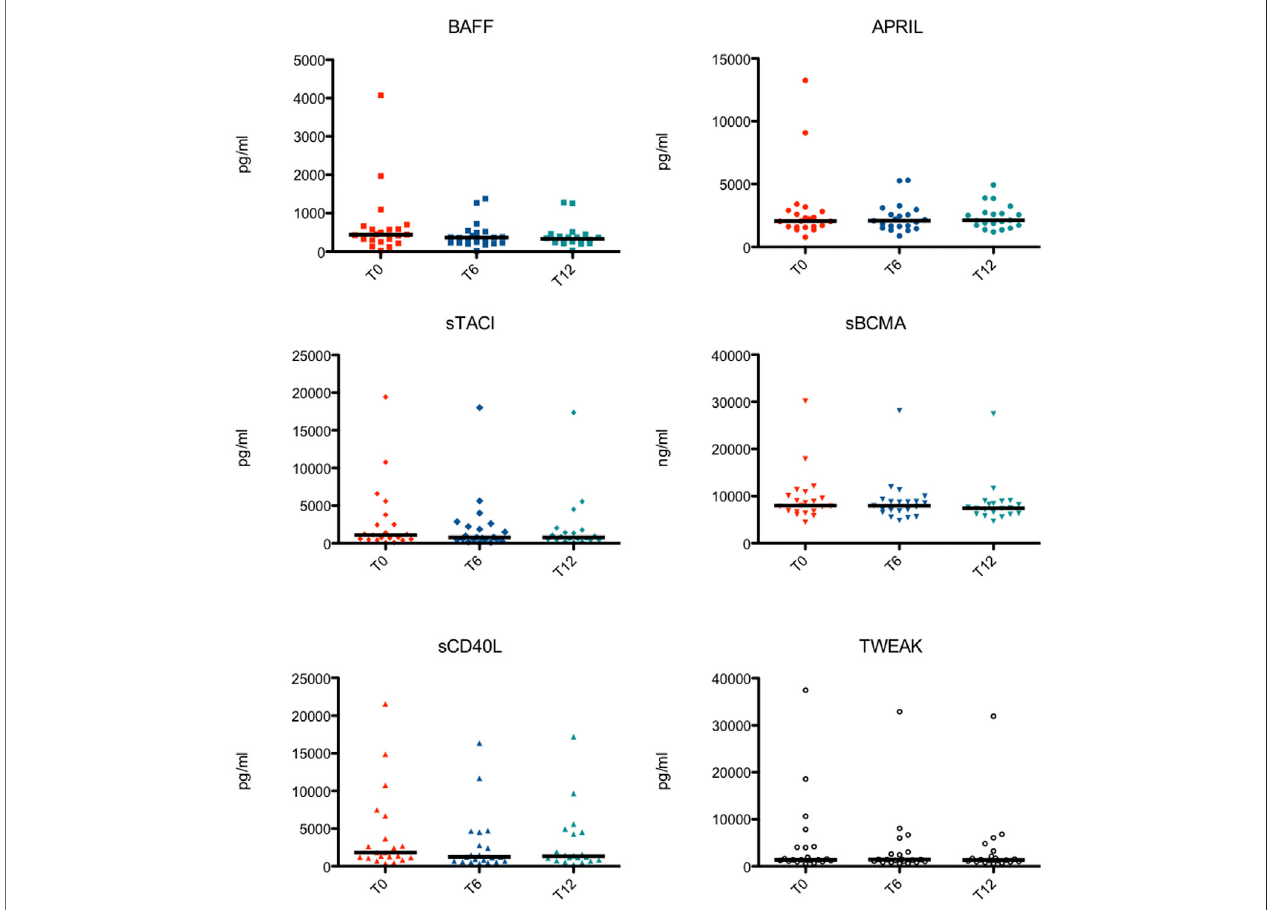
FIGURE1| SerologicallevelsoftheTNFSuperfamilymembersatdifferenttimepointsineachsubject.BAFF,Bcellactivatingfactor;APRIL,aproliferation-inducing ligand; sTACI, soluble transmembrane activator and calcium-modulator and cyclophilin ligand interactor; sBCMA, soluble B cell maturation antigen; sCD40L, soluble CD40 ligand; TWEAK, TNF-related weak inducer of apoptosis.